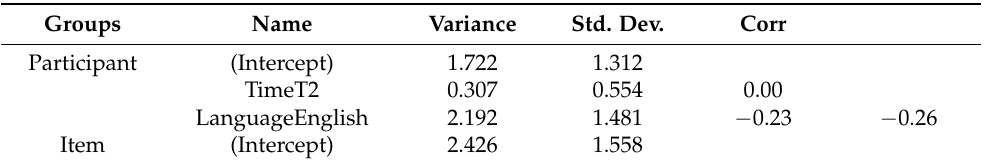
Table A5. Random effects of the logistic mixed-effects regression comparing performance in English and Arabic at T1 and T2 for the whole sample.